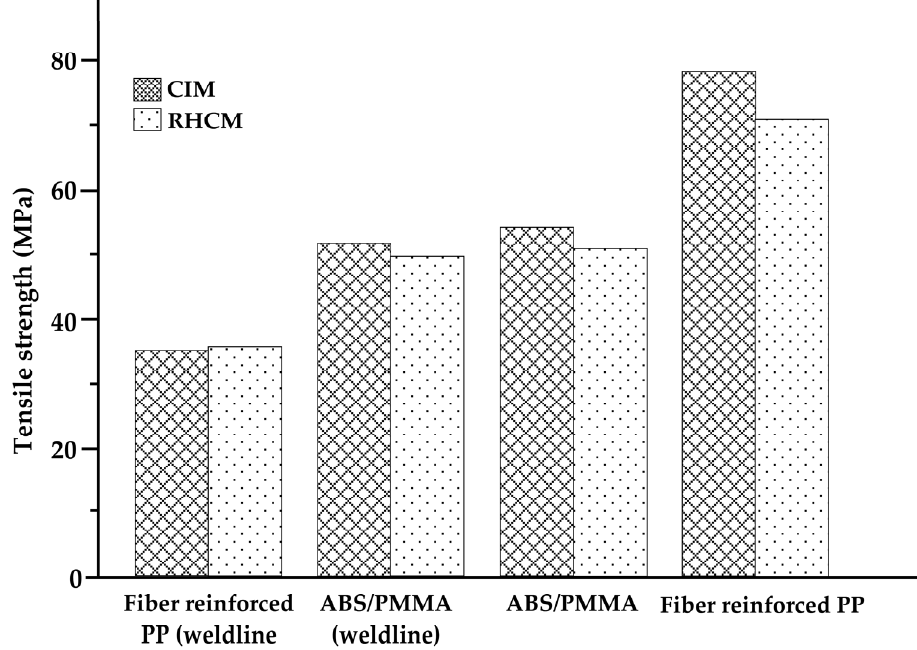
Figure 11. The tensile strength with and without the weld line of the CIM and RHCM